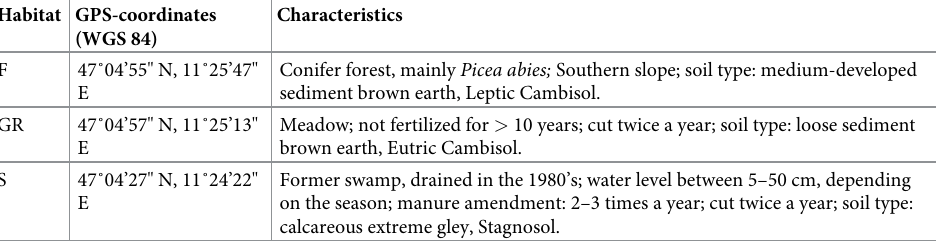
Table 2. Sites that were selected for soil analysis in order to demonstrate the functionality of CoMA. Habitat GPS-coordinates (WGS 84)